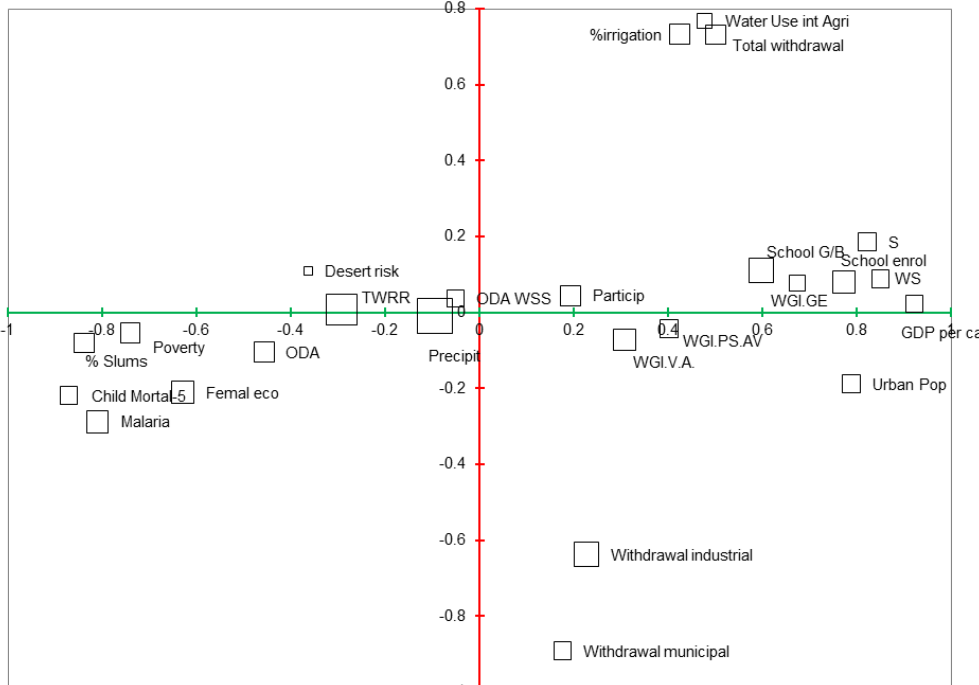
Fig. 2. Graphical representation of the WatSan4Dev variables in the three first components of the PCA (57%). The first component (HDP) is represented by the green axis; in red, the second component (AP); and, the size of the point represents the factor loading in the third component